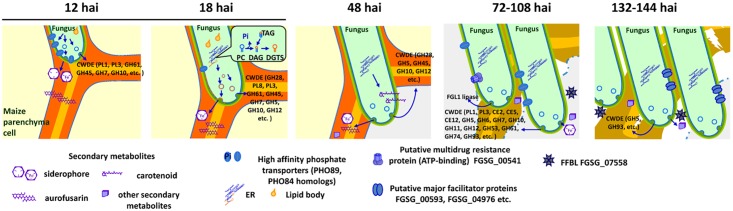
A hypothetical model of molecular events during maize stalk infection by F. graminearum, based on microscopic observation and gene expression profiling.At 12 h after inoculation (hai), the fungus grows between live parenchyma cells, secretes plant cell wall degrading enzymes (CWDE) mainly breaking primary chains of pectin (PL1, PL3), cellulose (GH61, GH45, GH7) and hemicellulose (GH12) for penetrating barriers, secretes secondary metabolites (siderophore and aurofusarin), and increases high affinity phosphate transporters; at 18 hai, the fungus continues to grow between live parenchyma cells, secretes similar CWDEs and secondary metabolites, but reduces the expression of high-affinity phosphate transporters, and deploys BTA1 to produce non-phosphorus membrane lipids to assure fast growth under phosphate starvation; at 48 hai, the fungus starts to grow into host cells and kills invaded and surrounding host cells, gains access to host cellular phosphate, reduces CWDE production as intracellular growth needs less cell wall breakage, and produces secondary metabolites such as carotenoids; around 72–108 hai, more CWDEs (including those targeting side branches of pectin) and FGL1 lipase are produced for full digestion of plant tissues, a toxic lectin FFBL is secreted, and a putative multidrug resistance protein is also produced; around 132–144 hai, the fungus grows among dead parenchyma cells, produces less CWDEs, more FFBL, and more major facilitator proteins. CAZy categories are indicated in parentheses after the respective CWDEs.